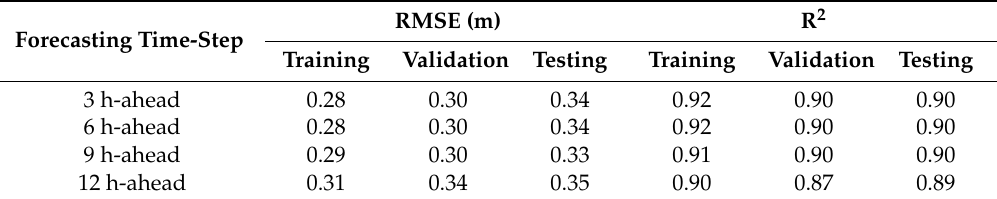
Table 4. Performance of 3 h-up to 12 h-ahead forecasting of ARID using RNARX based on 7 real events and 12 designed events.